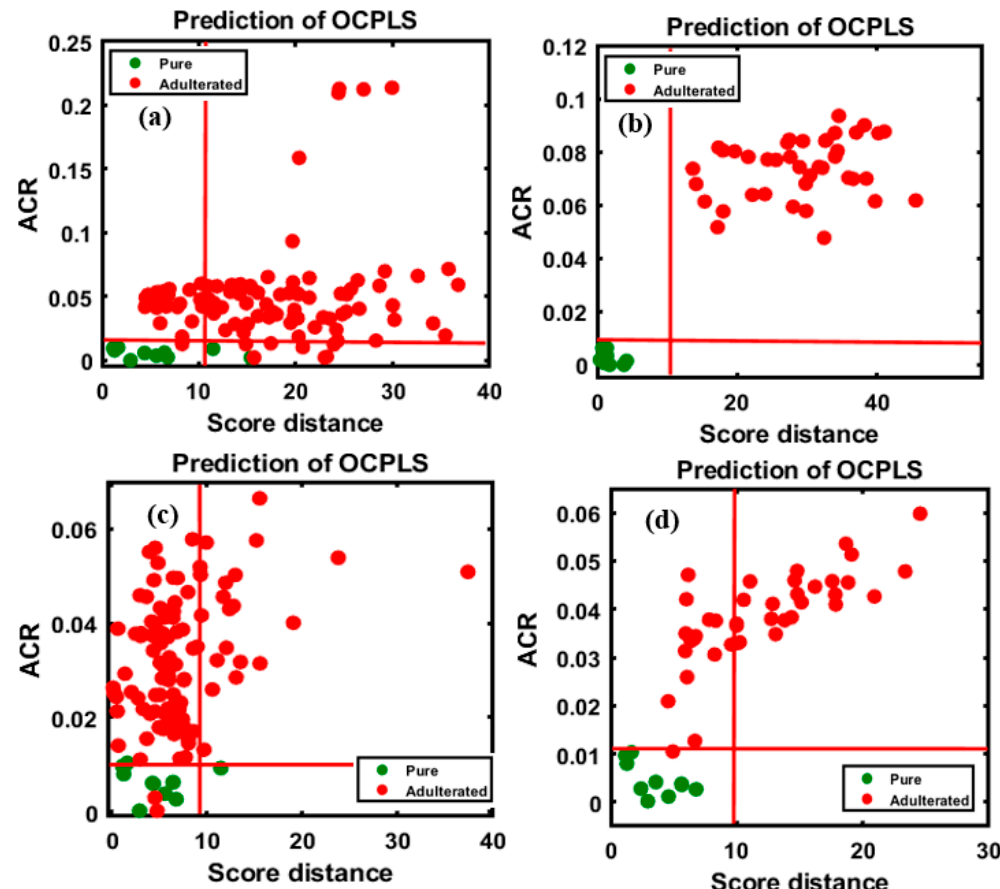
Figure 5. OCPLS-based classification plots for the four different FT-IR validation data sets: apricot-adulterated almond powder of the ( a ) 1st and ( b ) 2nd varieties, peanut-adulterated almond powder of the ( c ) 1st variety and ( d ) 2nd varieties.